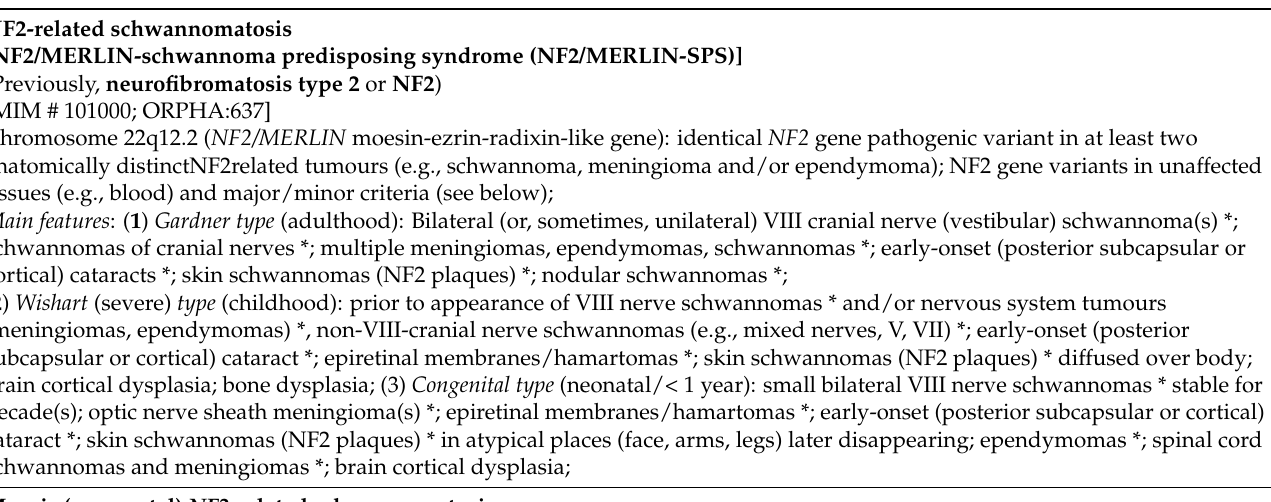
Table 7. NF2/SMARCB1/LZTR1-related schwannomatoses (schwannoma predisposing